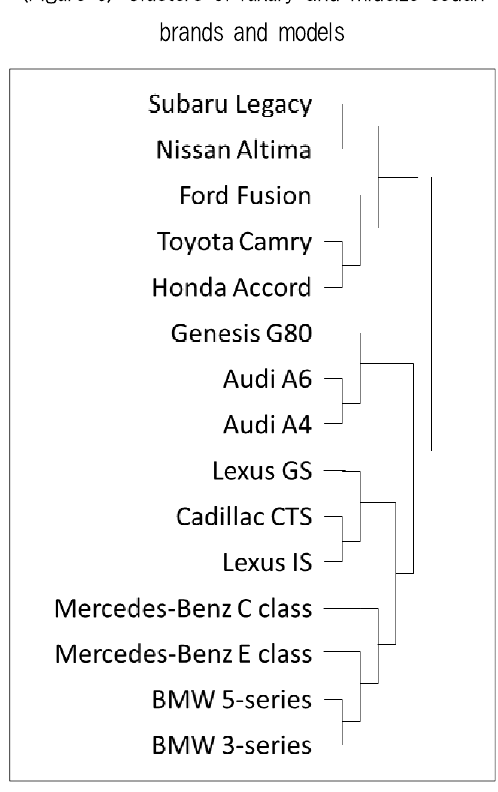
<Figure 6> Clusters of luxury and midsize sedan brands and